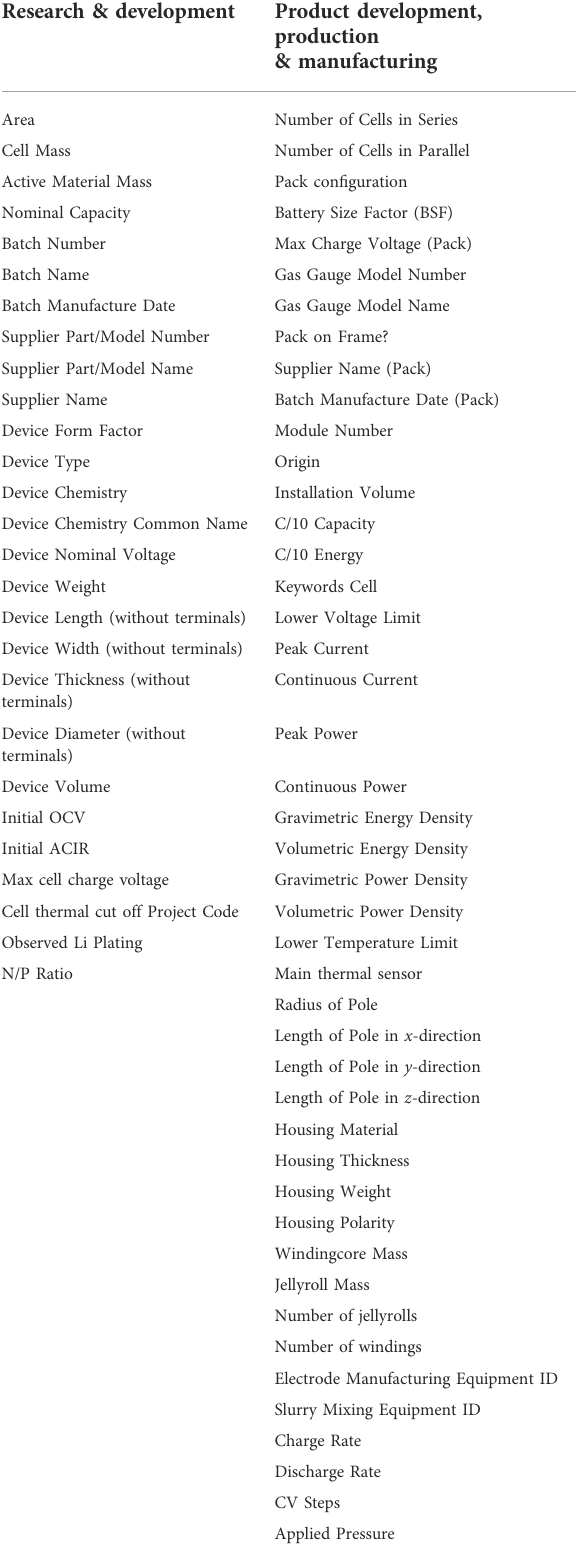
TABLE 3 Metadata to include in designated metadata fi le by battery lifecycle